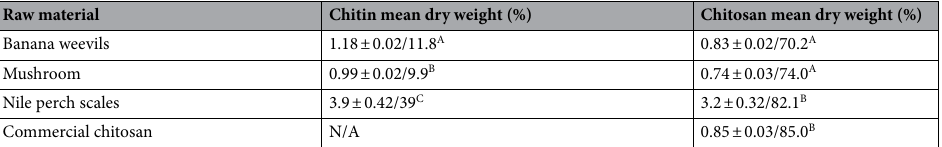
Table 1. Dry weight yield of chitin and chitosan isolated from locally available materials. Mean values in each column accompanied by the same letter are not significantly different ( P > 0.05) (Tukey Multiple Comparison) and values accompanied by letter (s) which are not similar are significantly different ( P < 0.05).